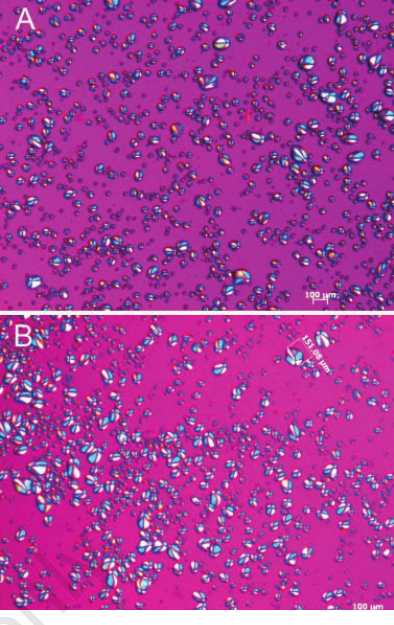
Figure 3. Distribution of starch granules taken from the pre-diluted juice (Method 4), from two potato cultivars. (A) Red Deer; (B) Yorkton. Microscopic objective: